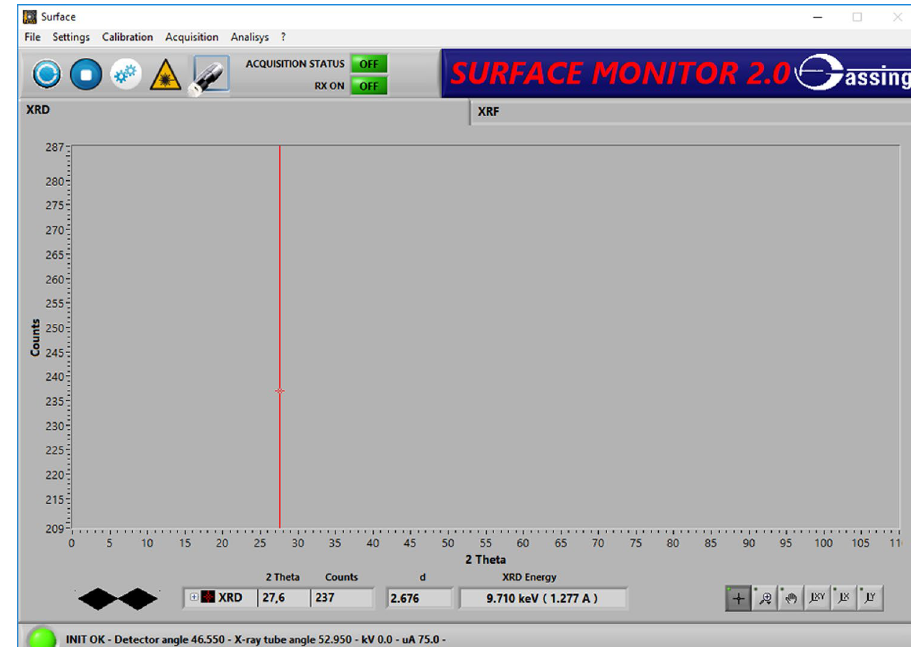
Fig. 3 The initial surface of the operation software